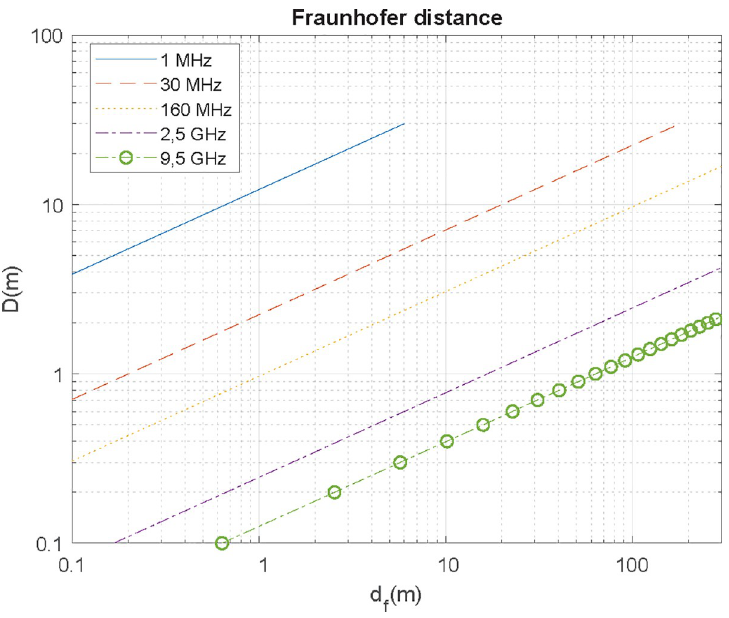
Fig 3. Far field distance as a function of antenna’s dimension for different wavelengths.